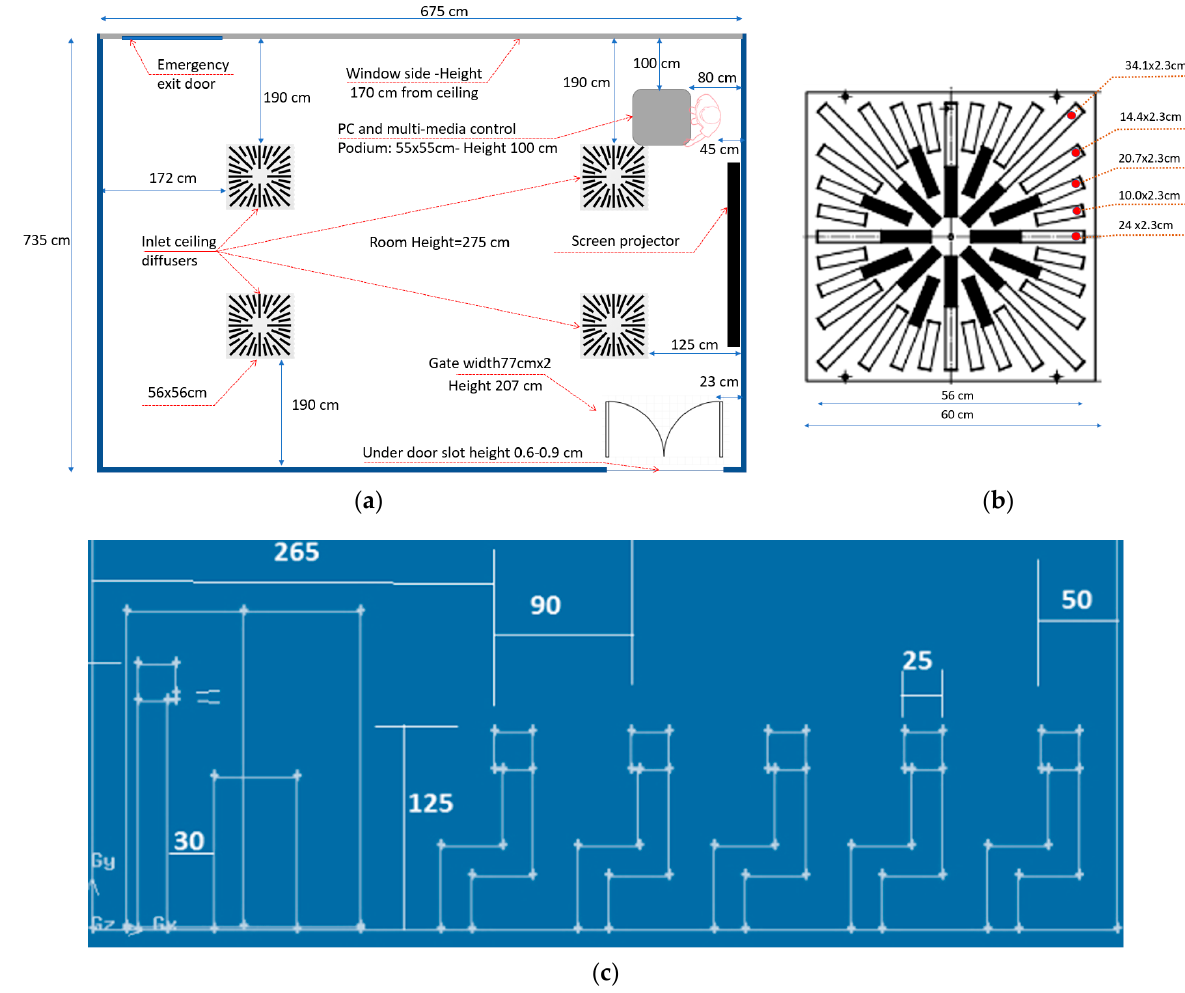
Figure 5. Main geometric dimensions of the exam room. ( a ) The layout of a typical classroom. ( b ) Main dimensions of the inlet ceiling swirl diffuser. ( c ) Locations of students’ seats.